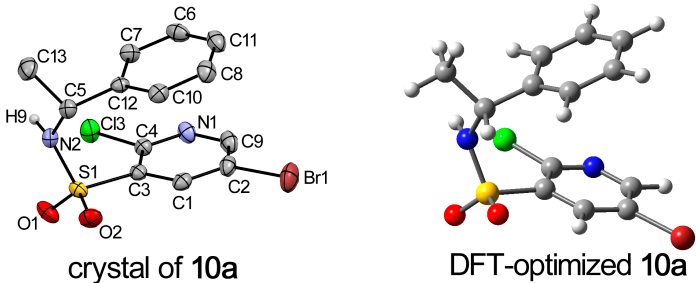
Figure 3. DFT-optimized and crystal structure of 10a ; displacement ellipsoids are drawn at the 30% probability level.